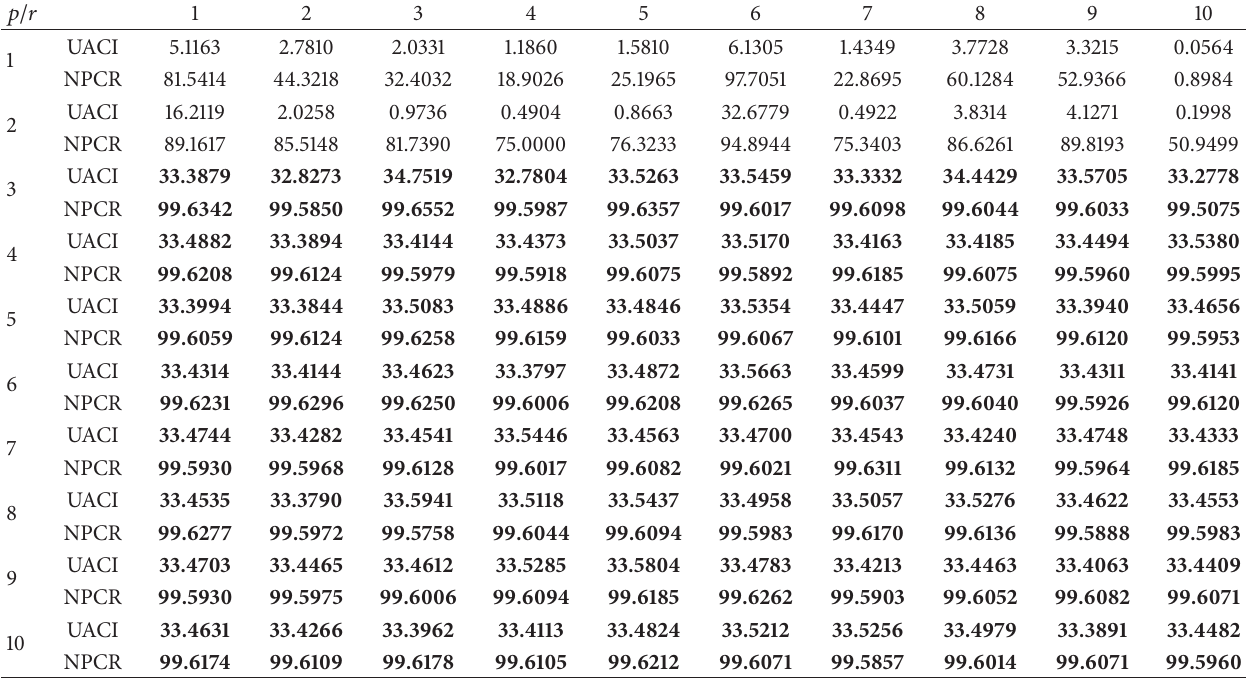
Table 10: Calculated UACI and NPCR for different combinations of 𝑝 and 𝑟 while 𝑞 = 1 in Peppers.